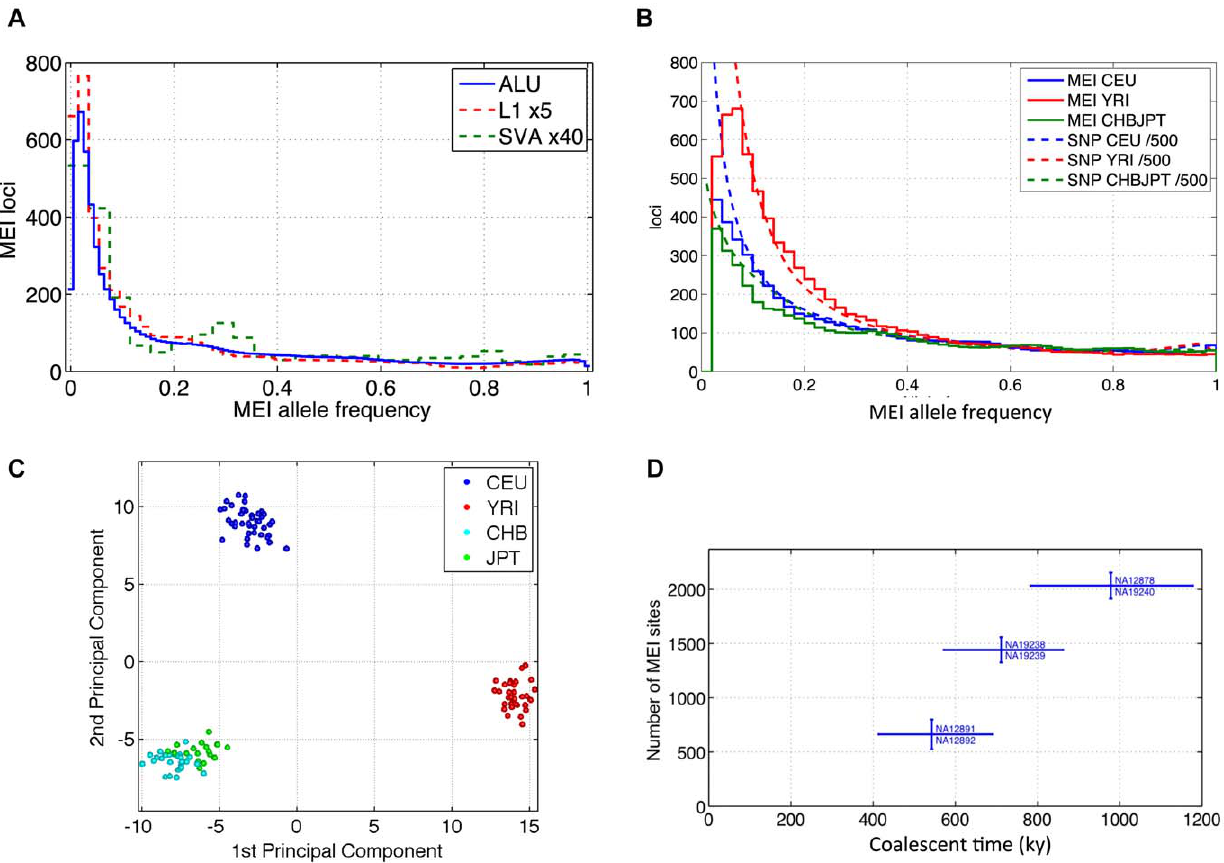
Figure 6. MEI allele frequency spectra, PCA, counts of variants between trio samples. a) Element family breakdown of the combined population allele frequency spectra. L1 and SVA are scaled up to allow comparison with the Alu spectrum. b) MEI and SNP allele frequency spectra across three population groups. The corresponding allele frequency spectra of SNPs relative to the ancestral genome from the 1000 Genomes low coverage pilot project are superimposed as dotted lines. The SNP spectra are scaled down by a factor of 500 for this comparison. c) Principal component analysis of MEI genotypes. CEU: blue; YRI: red; CHB: cyan; JPT: green. The first and second principal components are plotted. d) Total number of MEI between trio samples versus coalescent time based on SNP differences between the sample